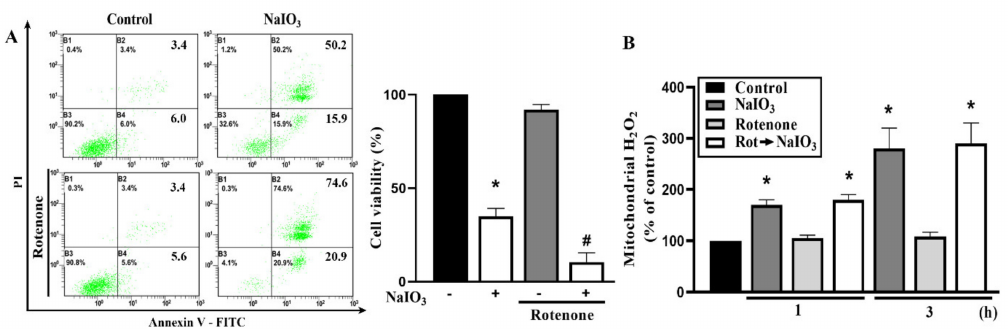
Figure 4. Rotenone enhances the NaIO 3 -induced retinal pigment epithelium (RPE) cytotoxicity. Cells were treated with rotenone (10 µ M) 20 min prior to NaIO 3 (30 mM) stimulation. Cell viability was measured by Annexin V / PI staining ( A ) and mitochondrial H 2 O 2 was determined by mitoPY1 staining ( B ). Data were mean ± SEM from three independent experiments. * p < 0.05, indicating the significant e ff ects of NaIO 3 . # p < 0.05, indicating the significant e ff ect of rotenone to increase cell death under NaIO 3